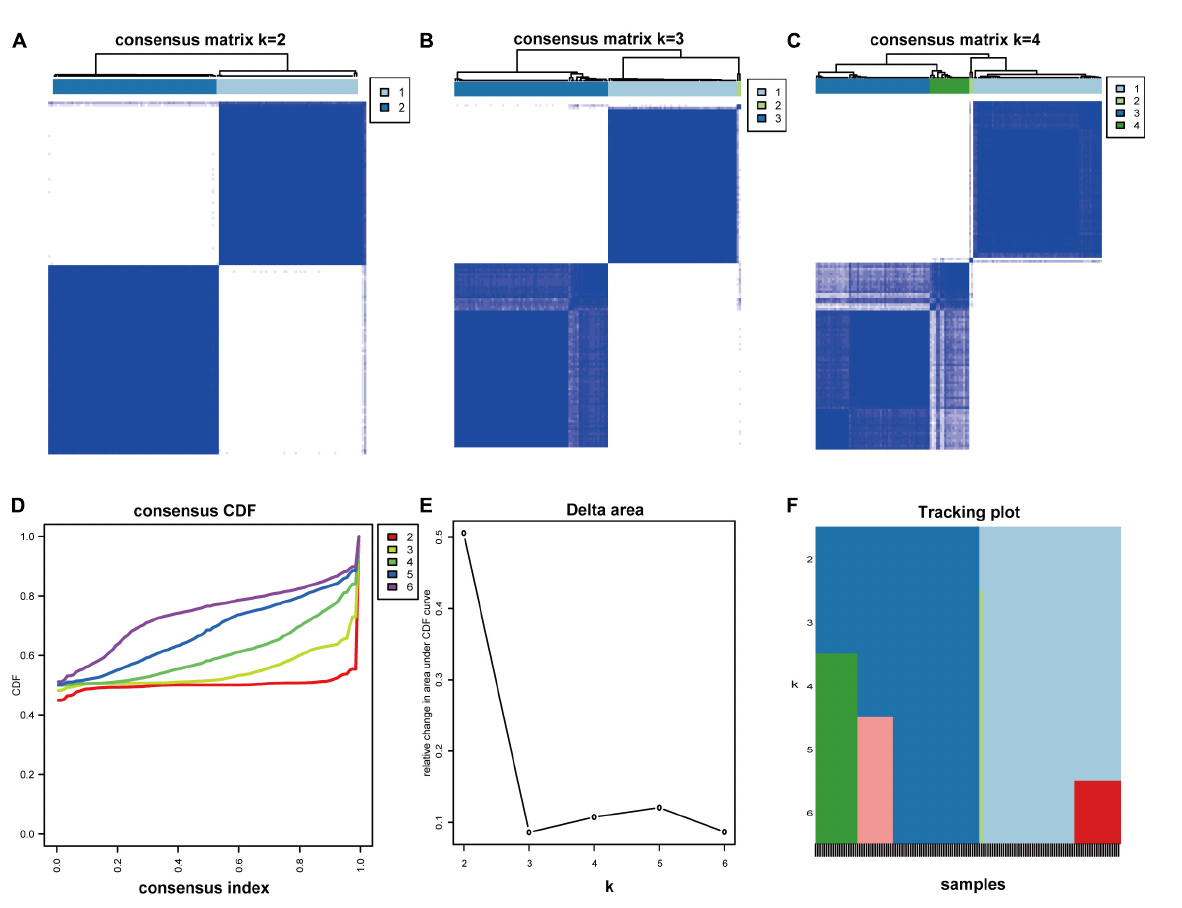
FIGURE4 Consensus clustering analysis. (A–C) Consensus matrix for k = 2 to k = 4. (D) The CDF value of the consensus index. (E) Relative change in area under CDF curve for k = 2–6. (F) The tracking plot for k = 2 to k =